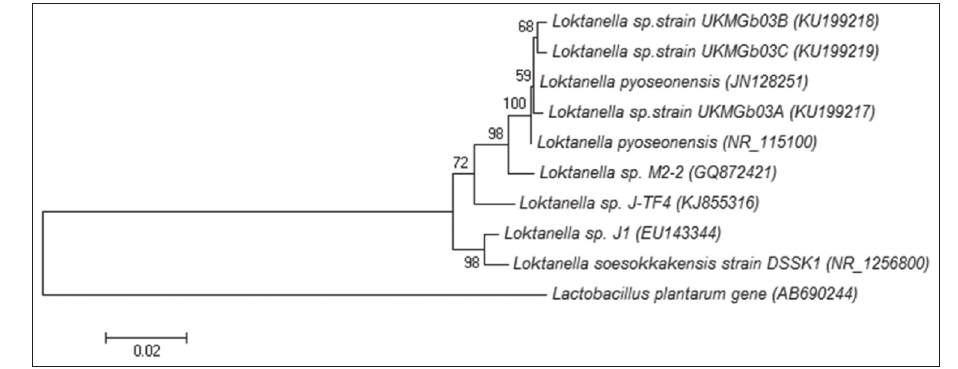
Figure-1: Phylogenetic Table-3: Algicidal activity of isolates against some Dinoflagellate using NB as control. Isolates